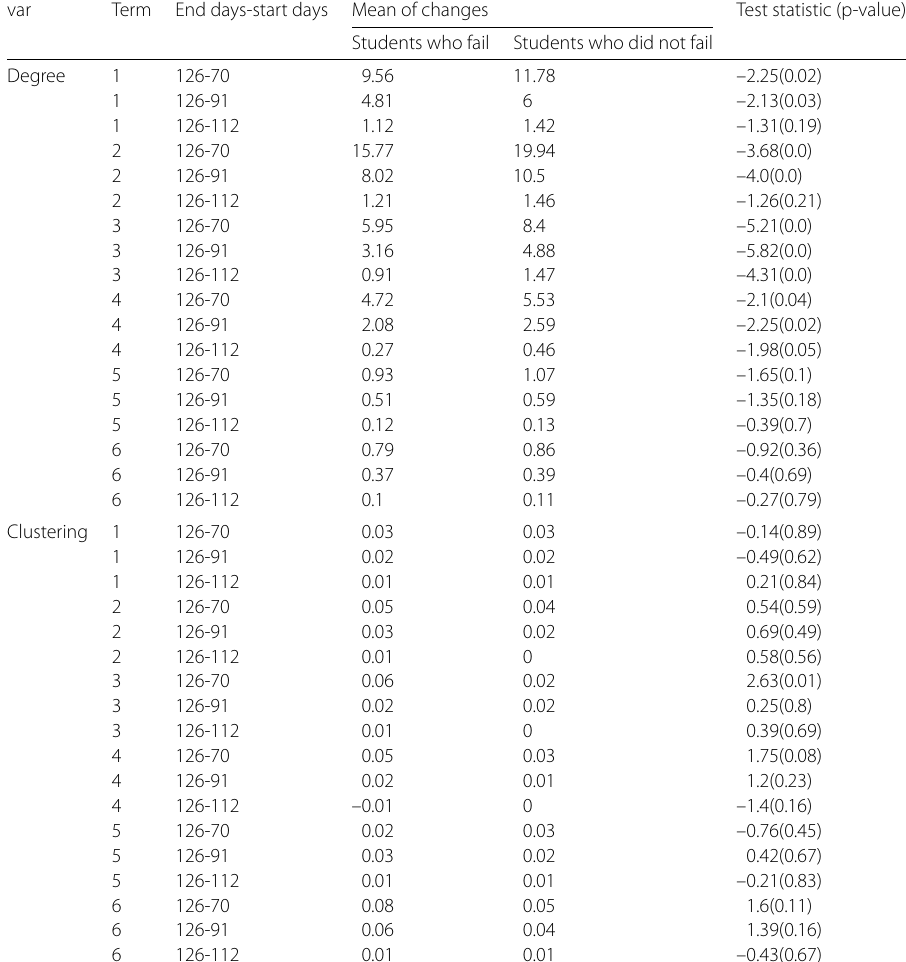
Table 1 T-test for the means of changes of degree (or cluster coefficient) for students who failed and who did not